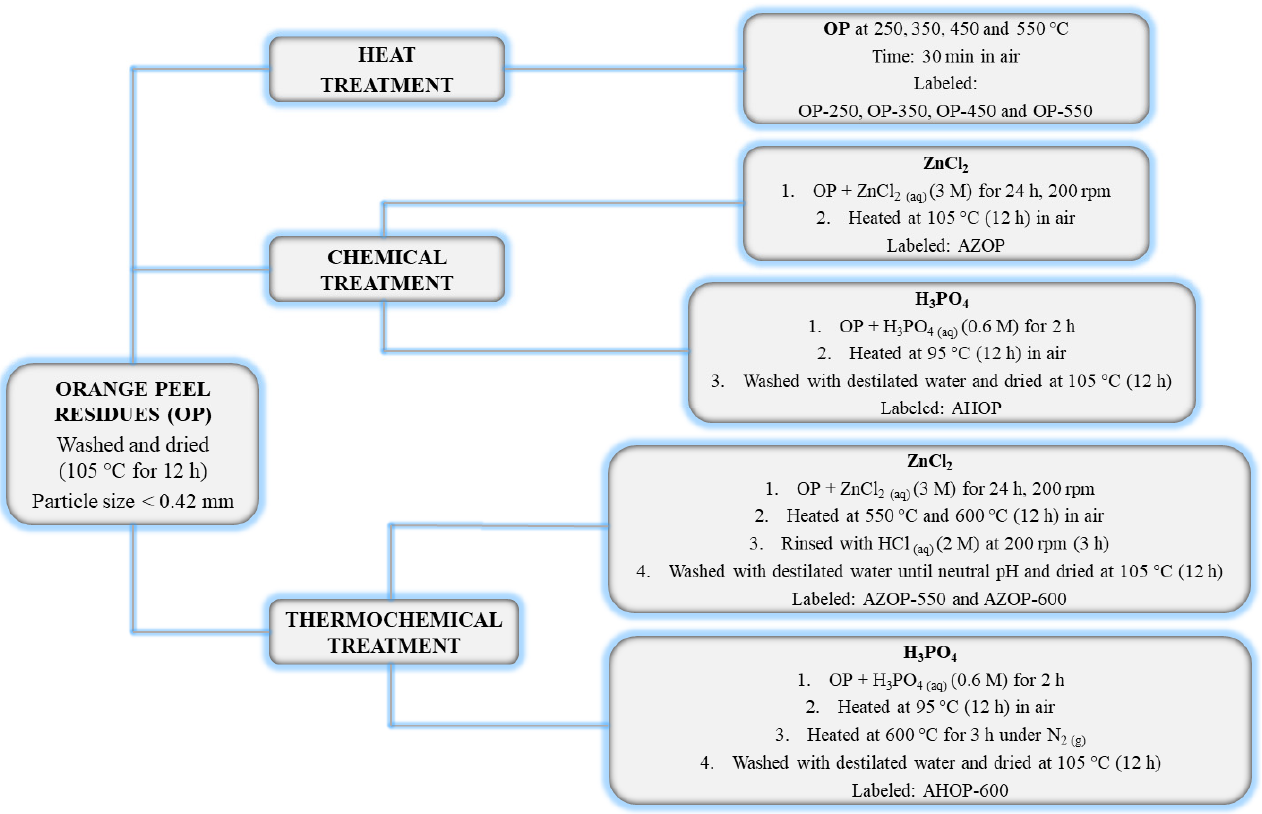
Figure 1. Orange peel transformation methods to obtain adsorbent